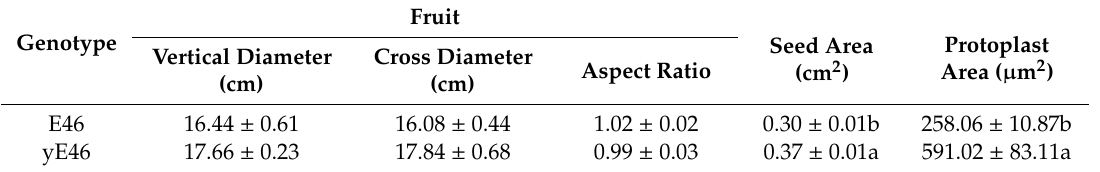
Figure 1. Plants ( A ), young leaves ( B ), seeds ( C ), and fruits ( D ) of diploid (E46, 2 ×) and tetraploid (yE46, 4 ×) watermelon. Table 1. Morphological comparison between diploid and tetraploid watermelon.